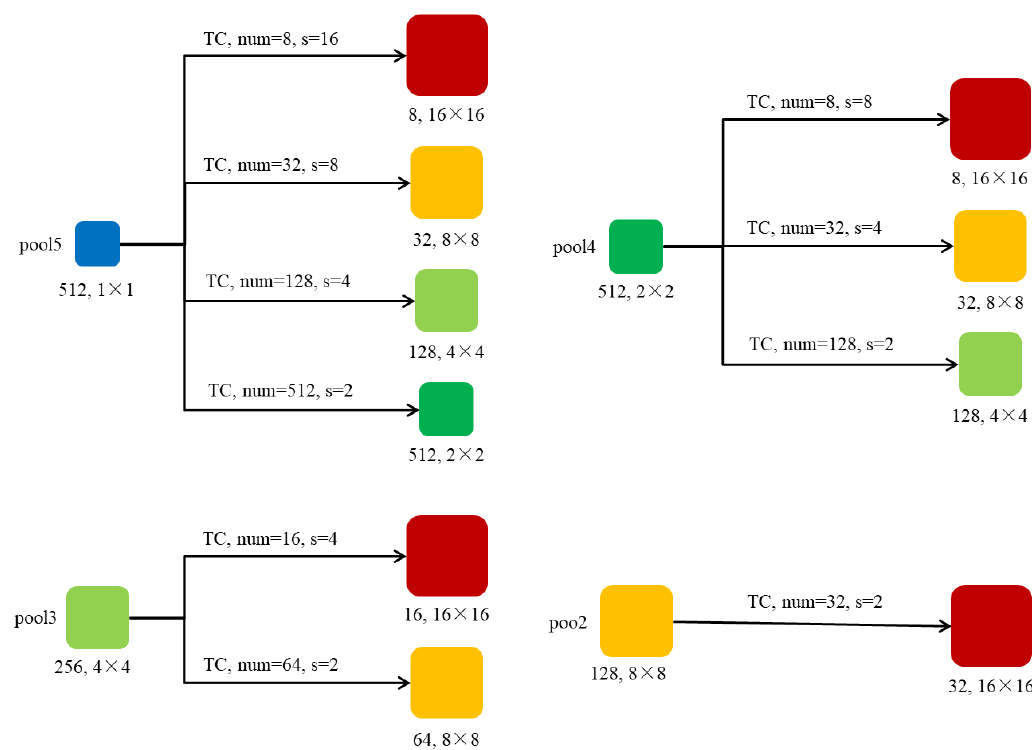
Figure 6. TC of each pooling result.